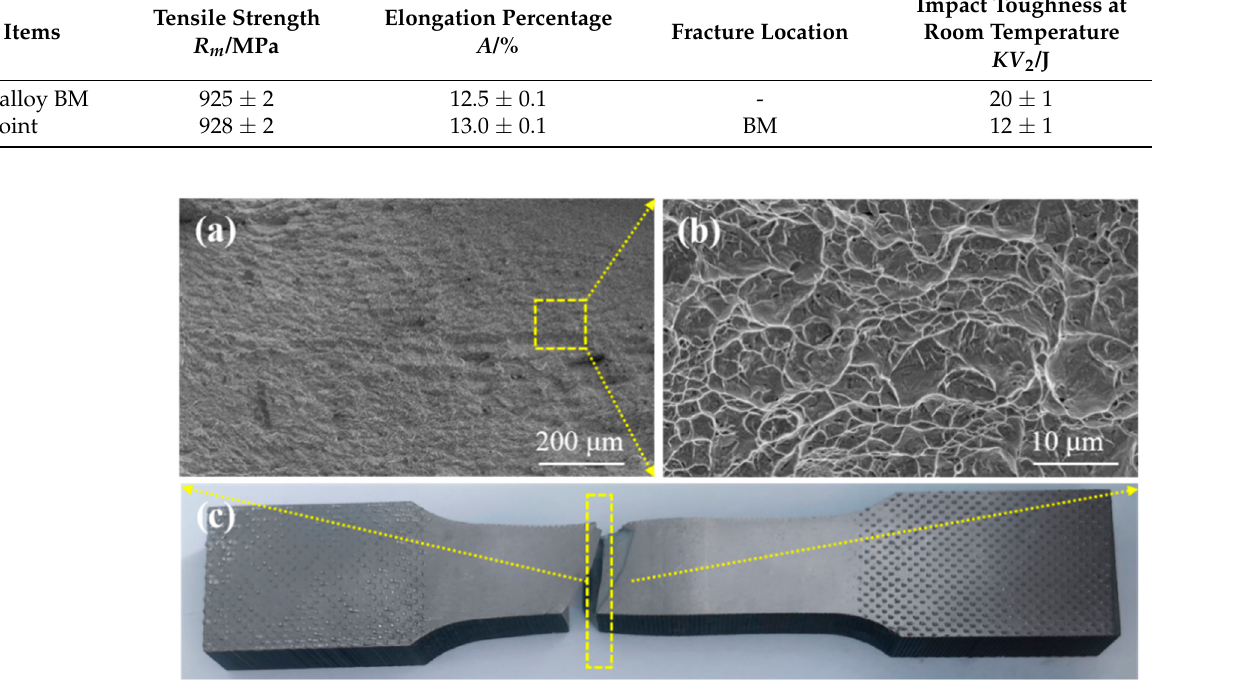
Figure 12. Tensile fracture location and fracture-side surface of the welded joint: ( a , b ) fracture-side surface; ( c ) tensile fracture location.